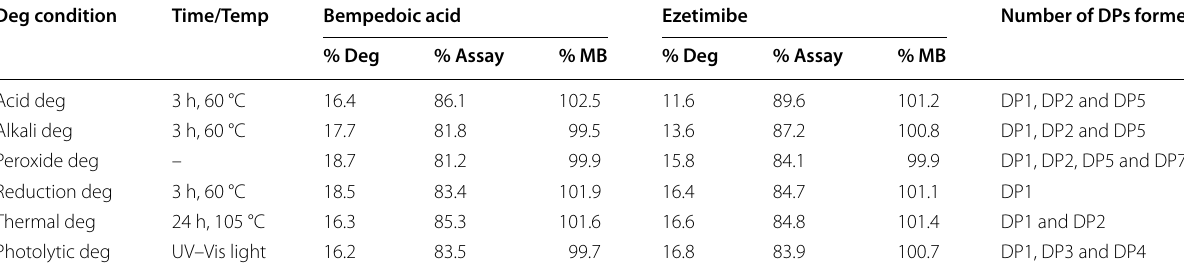
Table 6 Degradation results of Bempedoic acid and Ezetimibe Deg condition